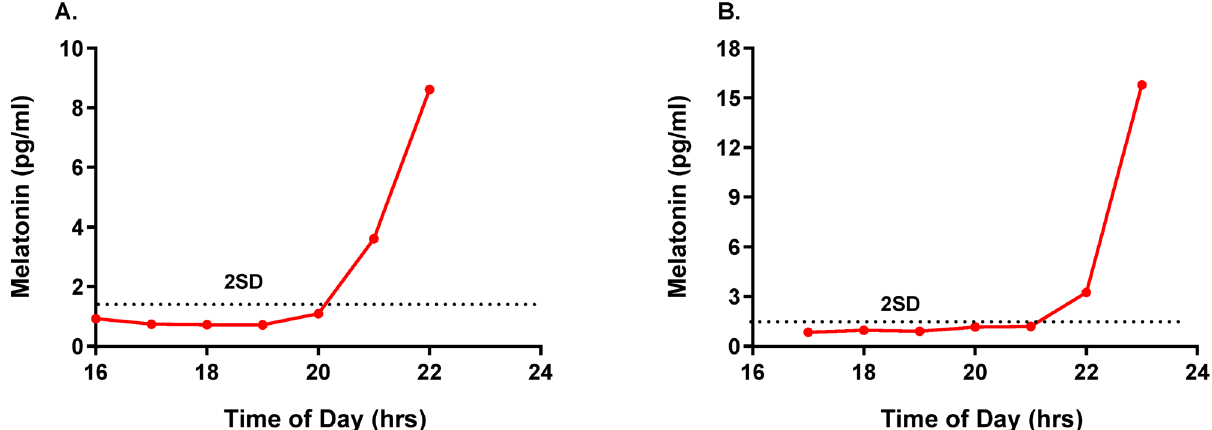
Figure 1. Representative salivary melatonin profiles collected under the dim light conditions in our AD patients. Dim light melatonin onset (DLMO)s were determined as a threshold calculated at 2 SD above the average baseline samples. In the presented AD patients, the DLMO was 20:01 ( A ) and 21:04 ( B ), respectively.